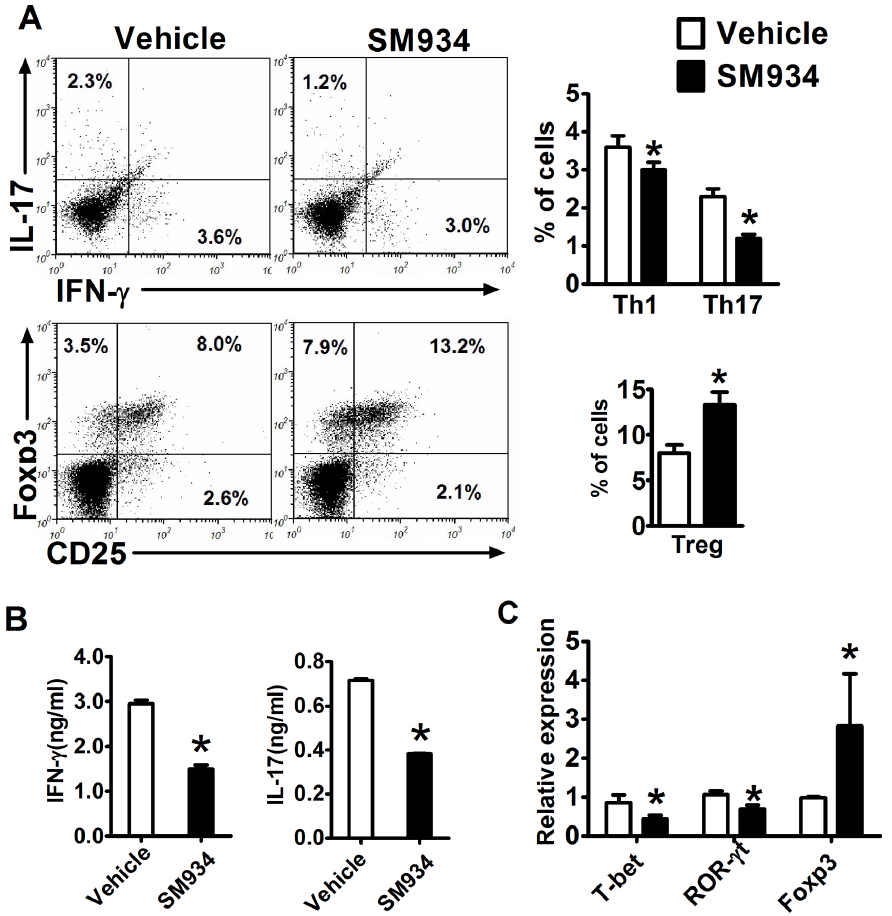
Figure 3. Effects of SM934 on the polarization of CD4 + T cells in EAE mice. Splenocytes from immunized mice treated with vehicle or SM934 were isolated at the peak of disease (day 18 p.i.) and analyzed. (A) The percentage of Th1, Th17 and Treg cells in the CD4 + gate were analyzed by flow cytometry, values in the bar graphs are the mean 6 SEM (n=4). (B) Splenocytes were re-stimulated with IL-12 (20 ng/ml) or IL-23 (20 ng/ml) for 72 hours, and supernatants were collected to measure IFN- c and IL-17 levels, respectively. (C) RNA from splenocytes was analyzed by real-time PCR for expression of T-bet, ROR c t and Foxp3. Results were expressed as mean 6 SEM. *, p , 0.05 compared with vehicle control. Three independent experiments were performed with similar